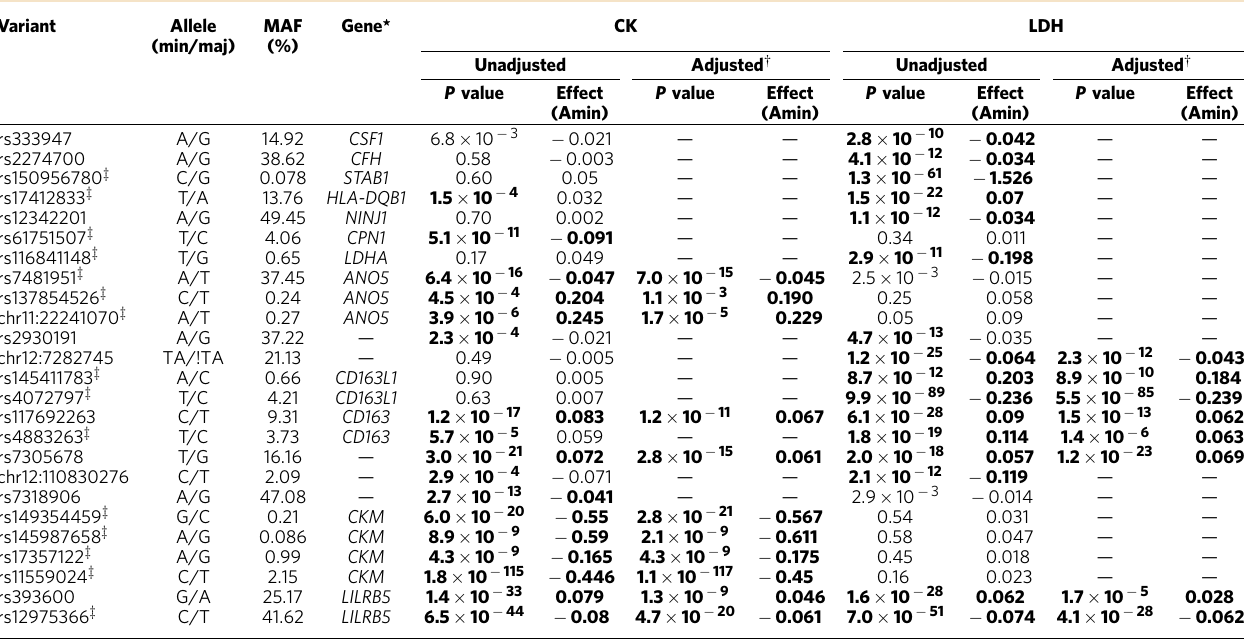
Table 1 | Summary of single marker associations for CK ( N ¼ 63,159) and LDH ( N ¼ 98,585) in Iceland.